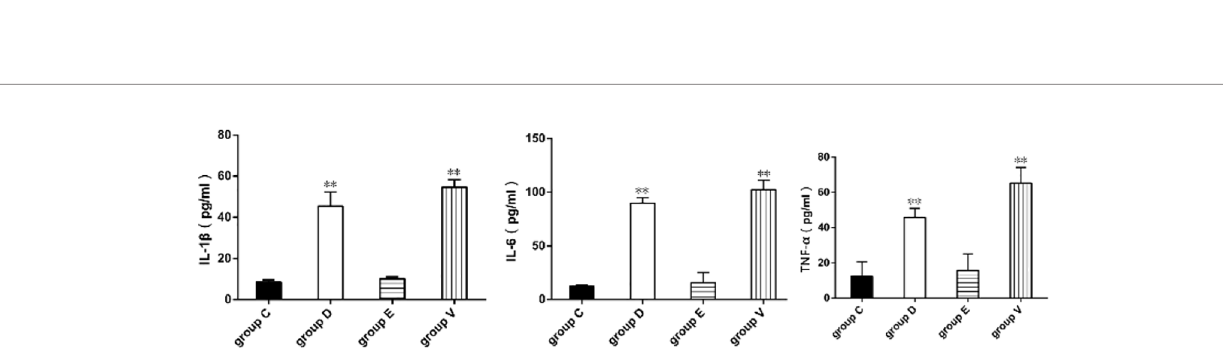
FIGURE 2 | Determination of redox biomarker. **represented signi fi cant difference ( P < 0.01). Statistical signi fi cance was evaluated by one-way analysis of variance (ANOVA) followed by Tukey ’ s multiple comparison test.